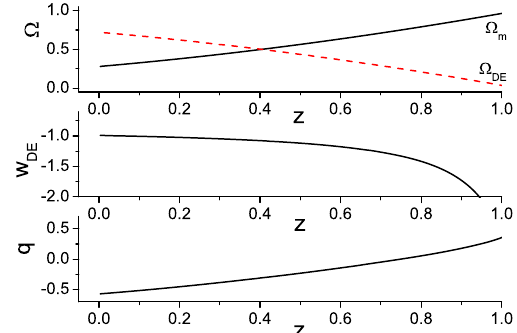
Fig. 1 Upper graph: The evolution of the effective dark energy density parameter (cid:10) DE (black-solid) and of the matter density parameter (cid:10) m (red-dashed), as a function of the redshift z , for the scenario of mod- ified cosmology through non-extensive thermodynamics with varying exponent, for the parameter choices (cid:2) = 0, b 1 = 0, n = 4, H 1 = 1 . 1 and b 2 = 1, in units where 8 π G = 1. Middle graph: The evolution of thecorrespondingdark-energyequation-of-stateparameter w DE .Lower graph: The evolution of the corresponding deceleration parameter q . In all graphs we have imposed (cid:10) DE ( z = 0 ) ≡ (cid:10) DE0 ≈ 0 . 7 at present in agreement with